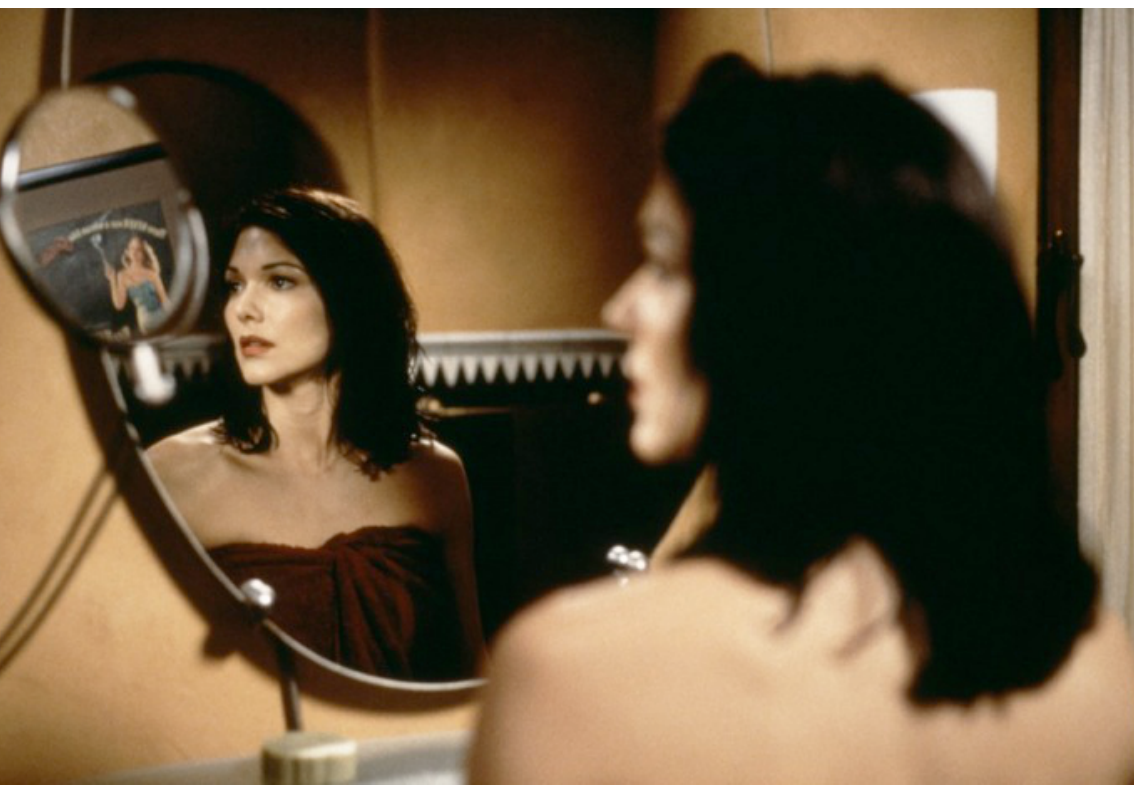
Figure 2: Camille looks at Gilda poster. Two characters mirror each other